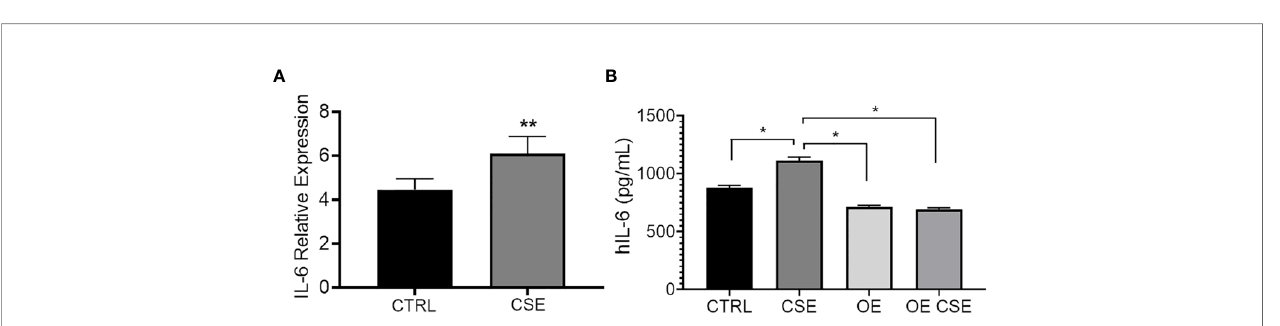
FIGURE 4 | IL-6 expression and secretion is increased following cigarette smoke exposure and attenuated by ST6GAL1 overexpression in HBECs. (A) Relative mRNA transcript levels of IL-6 in control (CTRL) and CSE treated HBECs. (B) IL-6 protein levels from supernatants of control, and ST6GAL1 OE HBECs exposed to CSE for 24 hours. CTRL, control; CSE, cigarette smoke extract/medium; and OE, ST6GAL1 overexpression. All experiments were reproduced 3 times and done in triplicates with bar graphs indicating means ± SEM with *p < 0.05 and **p <